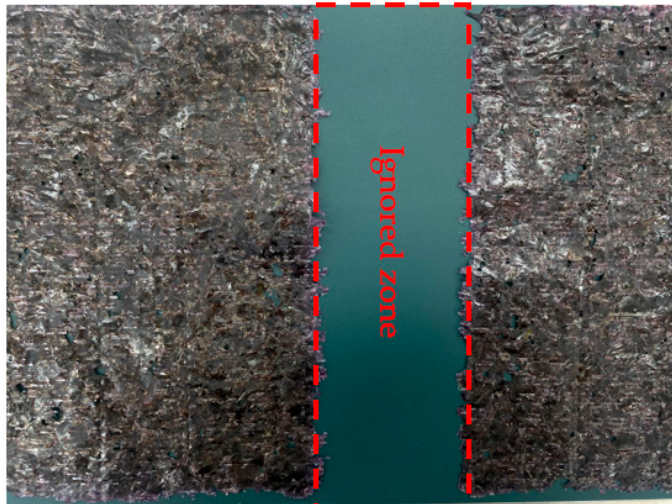
Figure 5. Example of an ignored zone.